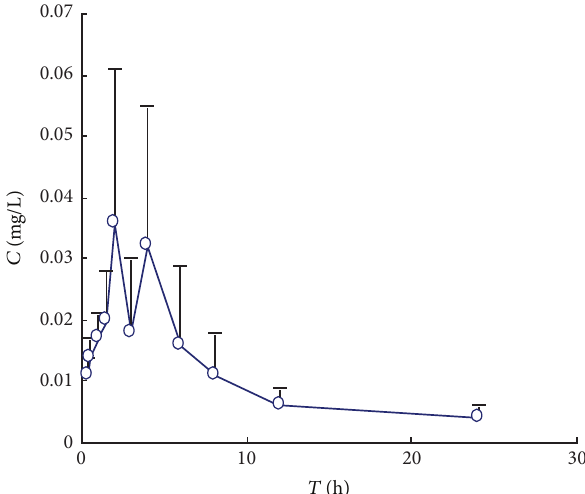
Figure 3: Mean plasma concentration-time curve of (4 E ,6 E ,12 E )- tetradecatriene-8,10-diyne-1,3-diyl diacetate after oral administra- tion of raw Atractylodis Rhizoma (40g ⋅ kg −1 ) to rats. (mean ± SD, 𝑛 = 6 ).